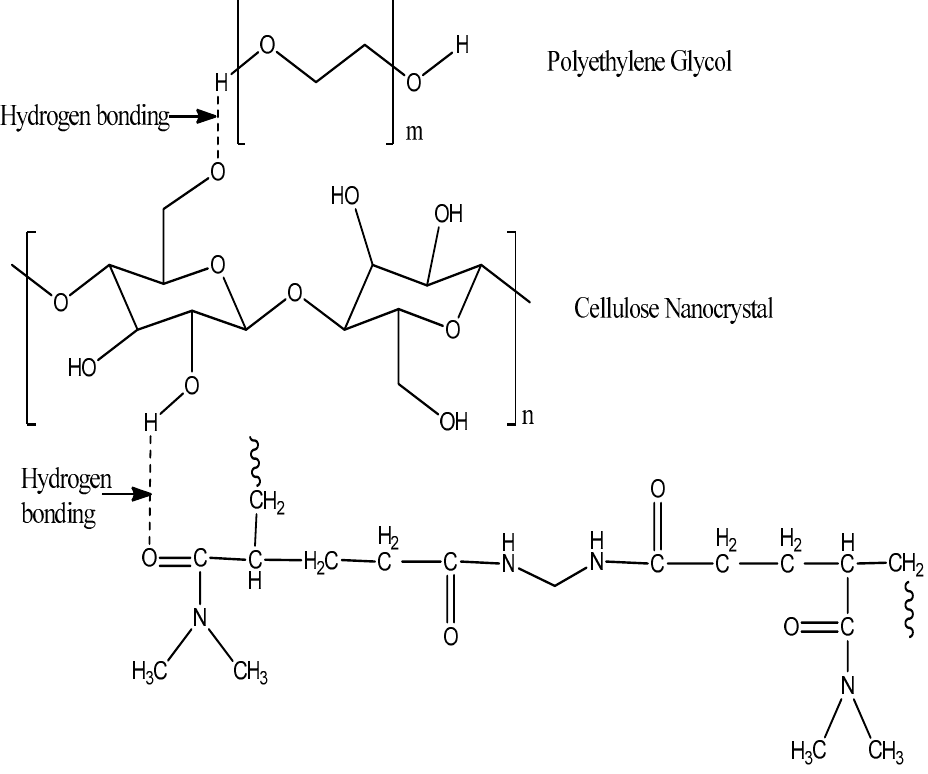
Figure 1. Proposed structure of semi-IPN hydrogel.